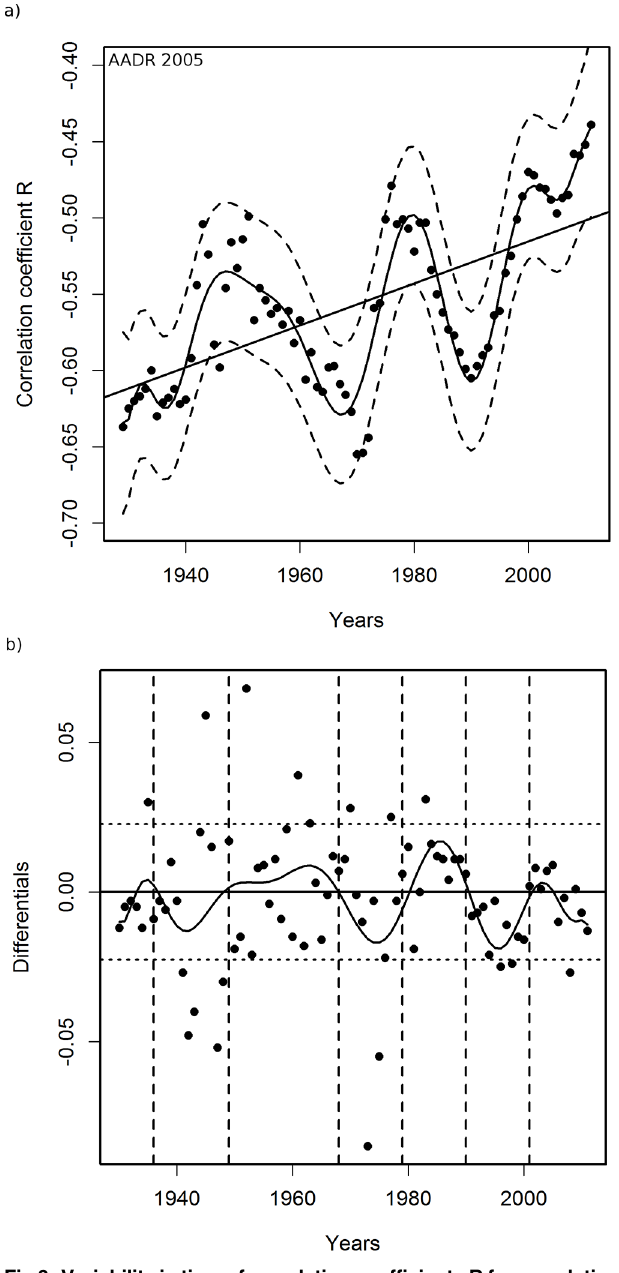
Fig 3. Variability in time of correlation coefficients R for correlations of PCPI (in 49 or 51 states of the USA) with age-adjusted AD death rates (AADRs) for the respective states in 2005. For years 1929 – 1949 PCPI data were available for 49 states. For years 1950 – 2011 PCPI data were available for 51 states. Solid line represents the regression curve obtained from polynomial (16 th degree) regression with 95% confidence intervals marked by dashed